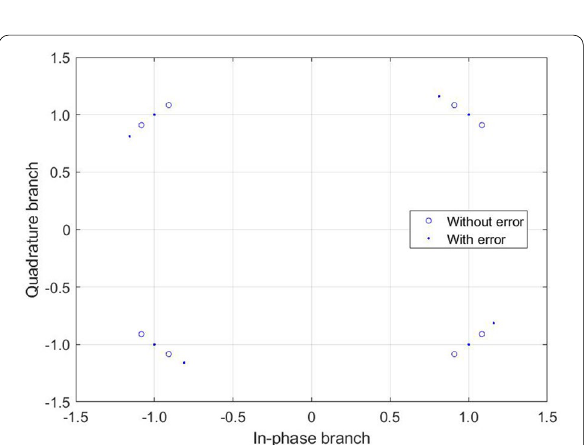
Fig. 9 ROC performance ( C (cid:31) N 0